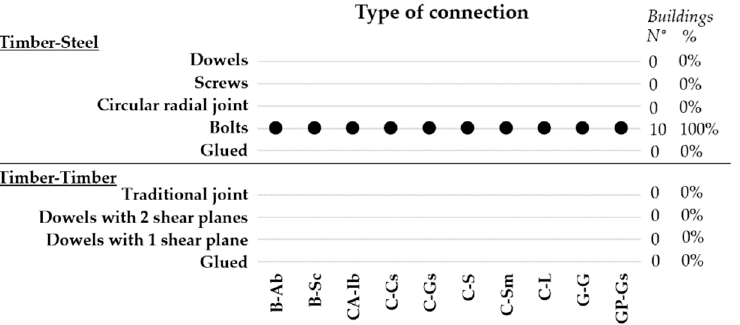
Figure 24. Section 3D CARTIS-Districts. Characterization of timber type: Type of connections.